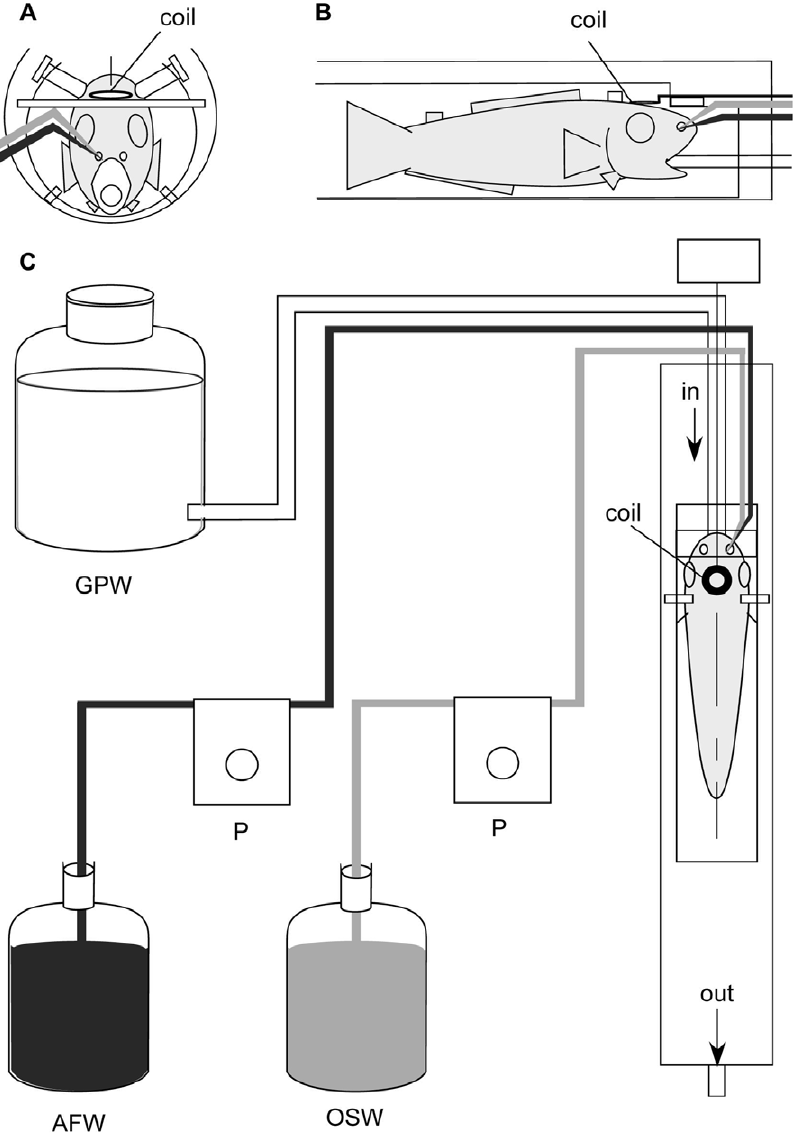
Figure 3. Schematic drawing of the animal-holding device containing an anesthetized sockeye salmon. A: frontal view; B: side view; C: water flow-through system mounted in the bore of the magnet during the magnetic resonance imaging experiment and the olfactory stimulus delivery system. The gill perfusion tube was fixed in the mouth of the fish. Odor stimulant water and AFW (artificial fresh water) water perfusion tubes were fixed in the right nasal cavity. coil, 1 H transmit/receive surface-coil (diameter: 5 mm); OSW, odor stimulant water; GPW, gill perfusion water; P, peristaltic pump.